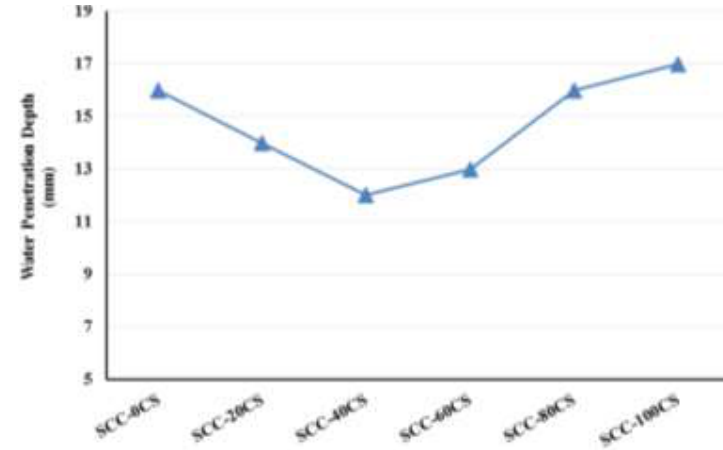
Figure 10. The depth of water